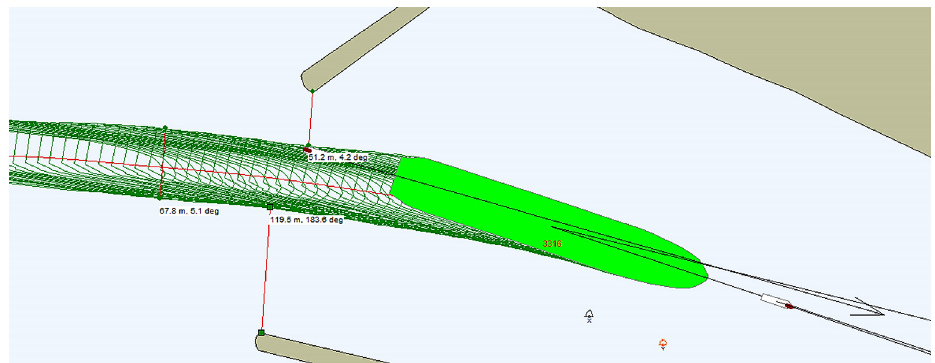
Figure 6. The SUEZMAX tanker entering the port under the SW wind of 14 m/s and measurements made using the SimFlex 4 simulator (FT